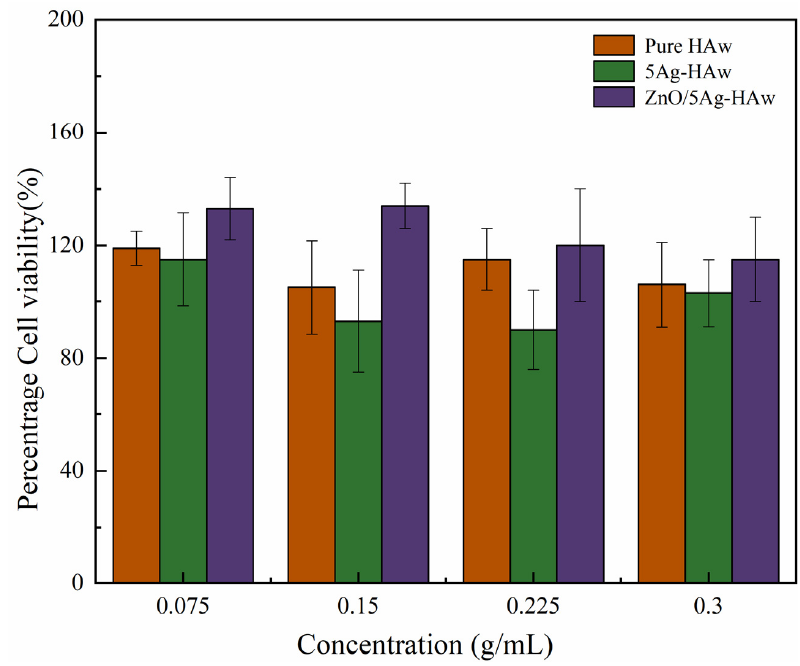
Figure 3. Results of the CCK-8 assay.